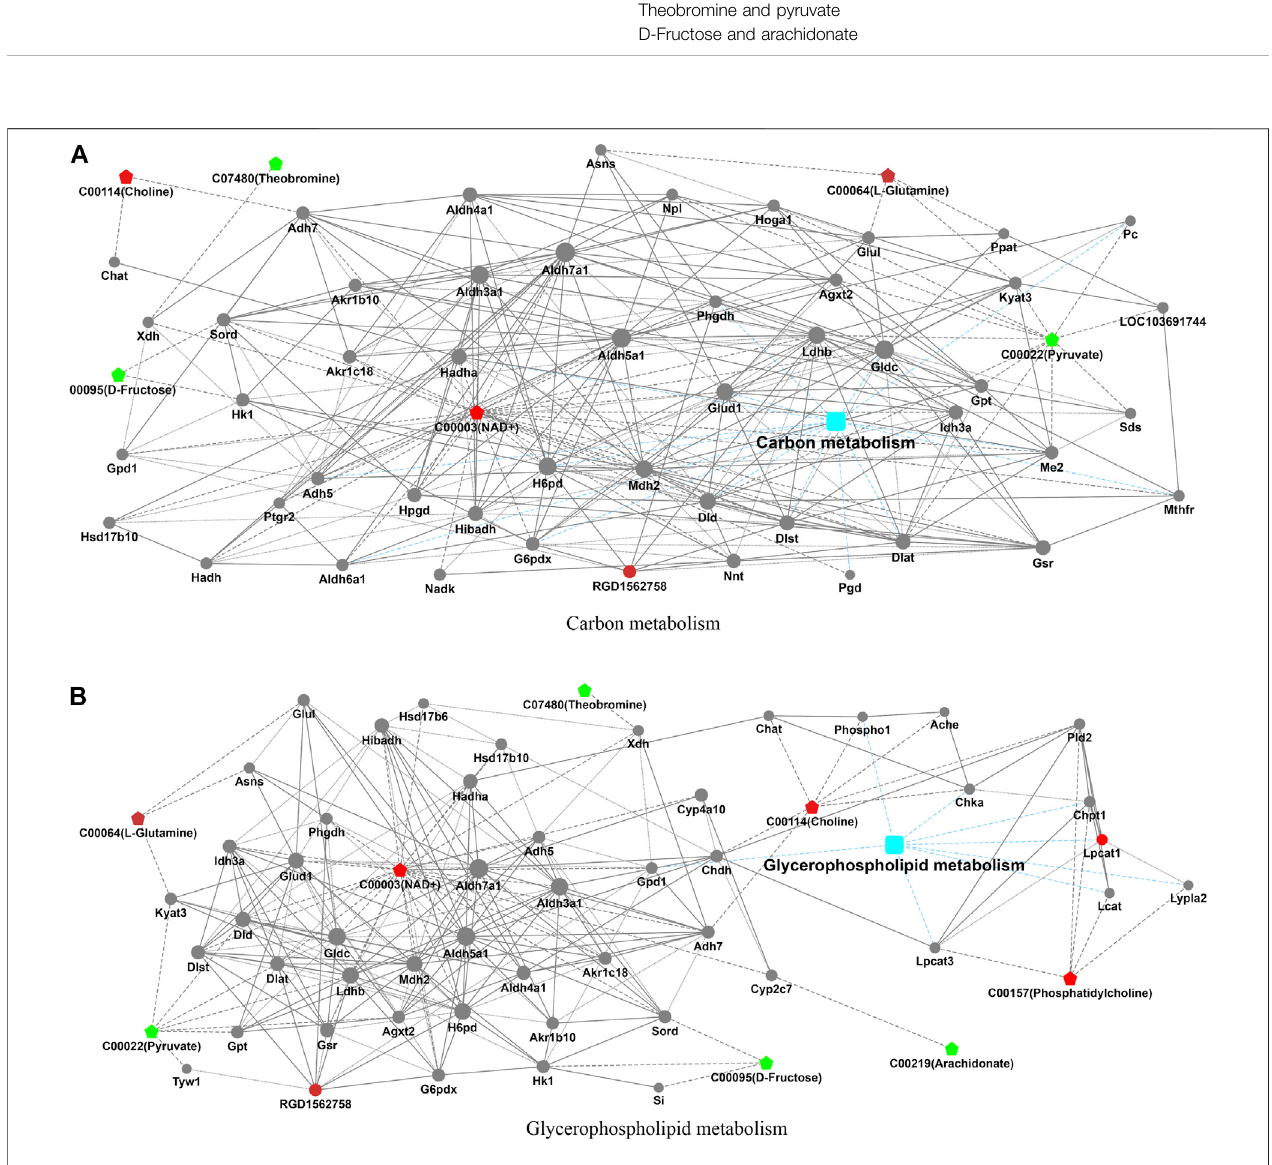
FIGURE 3 | Integrated analysis of proteomics and metabolomics. The integrated pathways analysis results of proteomics and metabolomics showed that carbon metabolism pathway (A) and glycerophospholipid metabolism pathway (B) are the relevant pathway of integration analysis. (boxes represent proteins, circles represent metabolites, red represents upregulation, and blue represents downregulation).